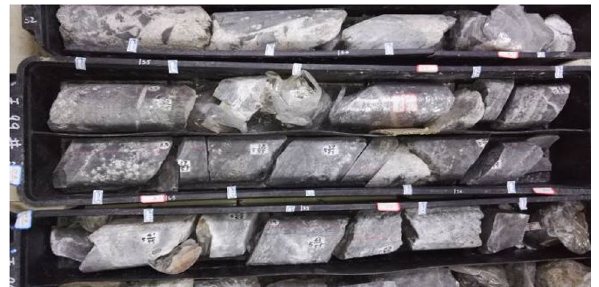
Table 1 Parameters and results of uniaxial and triaxial compression tests